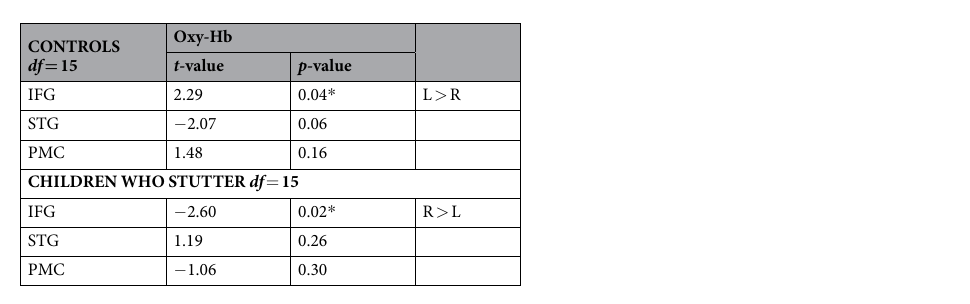
Table 3. Within group paired-sample t- tests for laterality comparisons of Oxy-Hb response amplitudes collapsed across channels for each ROI: left vs. right. * p ≤ 0.05. df = degrees of freedom; IFG = inferior frontal gyrus, STG = superior temporal gyrus, PMC = premotor